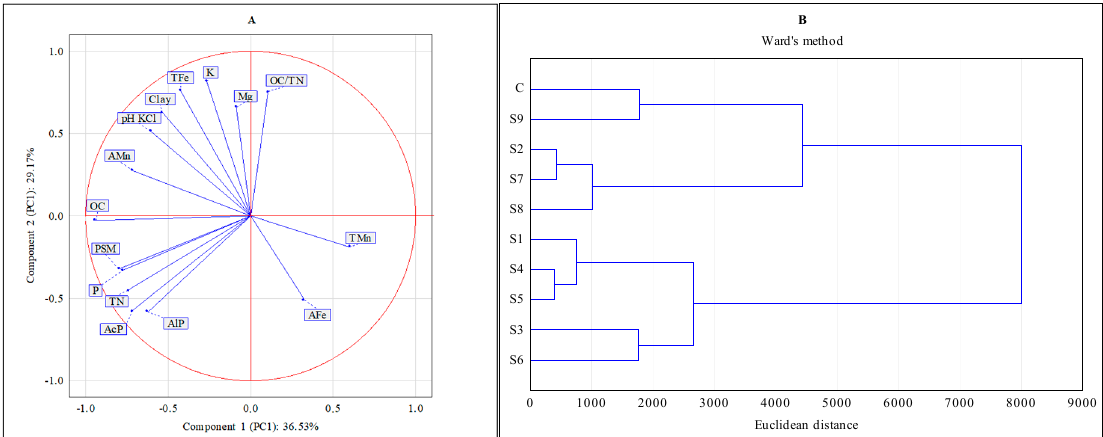
Figure 6. Configuration of variables in the system of the first two axes PC1 and PC2 of principal components ( A ); cluster analysis ( B ). In spring.